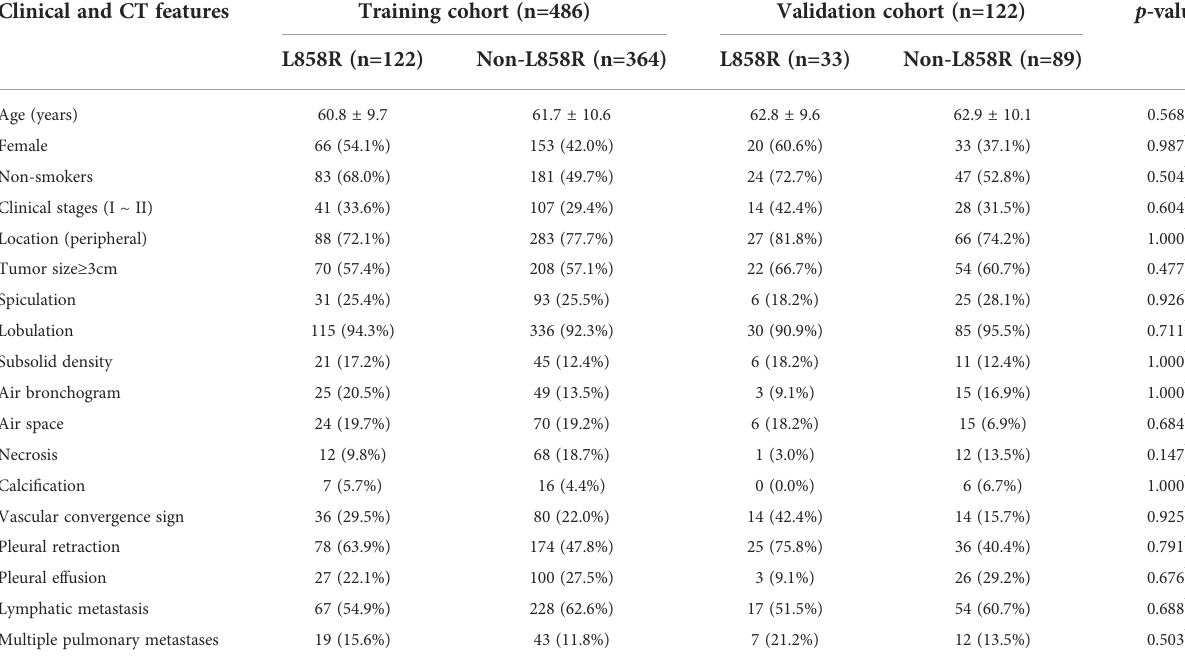
TABLE 4 Clinical and CT morphological features of patients with LADC in training and validation cohorts of model 3. Clinical and CT features